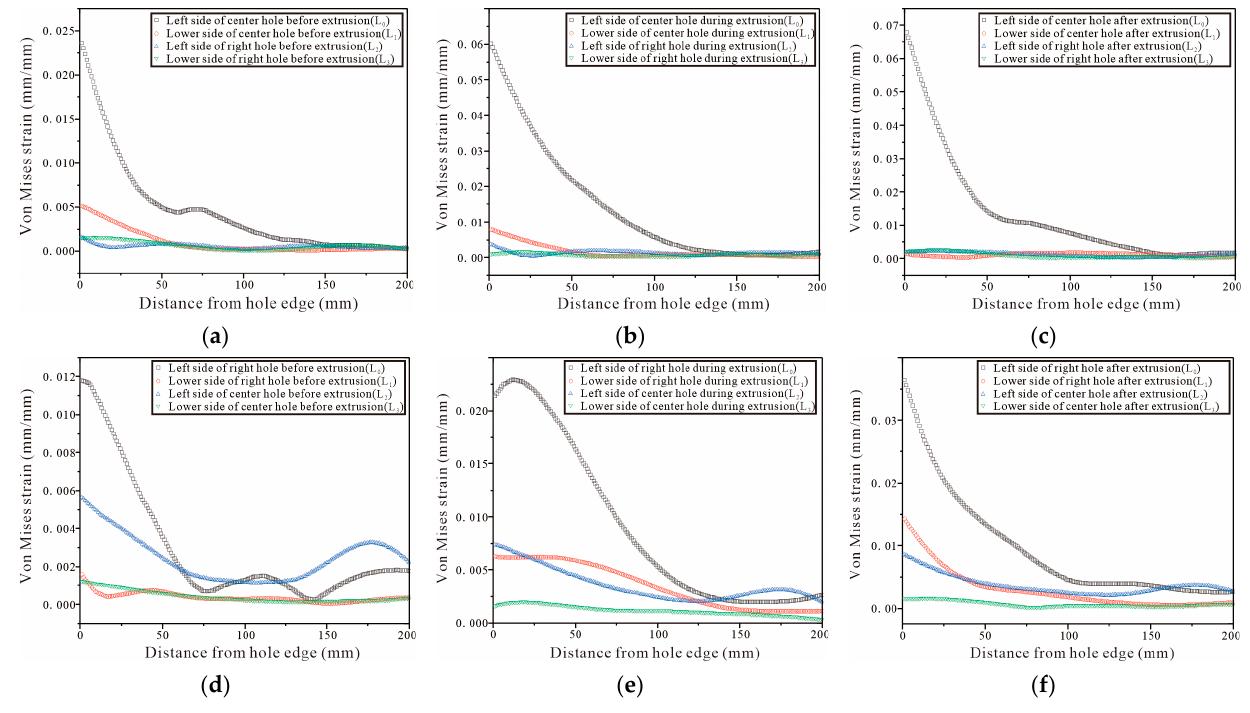
Figure 28. Von Mises strain results for the left and lower sides of the triple-pitch three-hole specimens (sequential SSCE): ( a – c ) strain distributions before, during, and after SSCE of the middle hole; ( d – f ) strain distributions before, during, and after SSCE of the right hole.